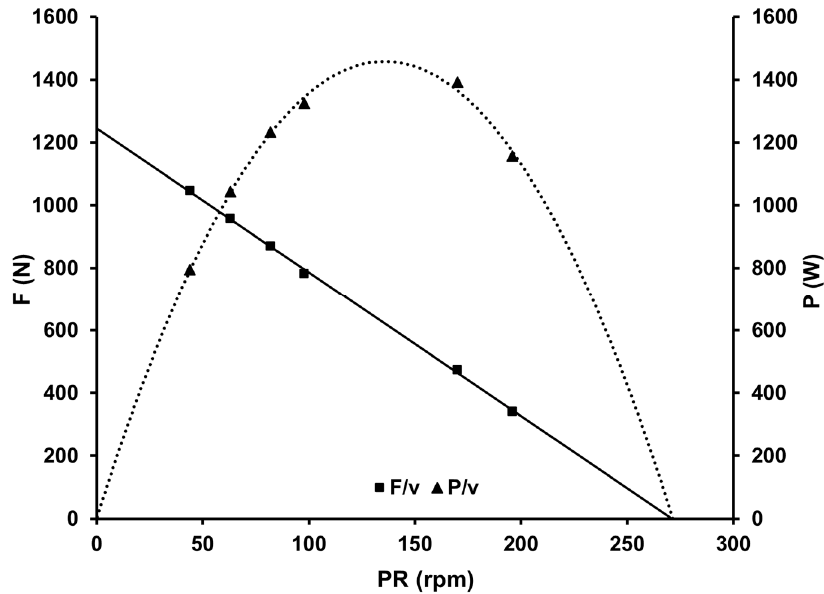
Figure 1. The fatigue-free force-velocity and power-velocity profiles for a professional track cycling sprinter calculated on the basis of the force and velocity data derived from the first 3 s of acceleration during the motoric and the sprint test. The solid line represents the F/v and the dotted line represents the P/v function. The maximal mean pedal force was 1223 N and the maximal pedaling rate was 277 rpm, resulting in a fatigue-free optimal pedaling rate of 139 rpm. For both profiles, R 2 was